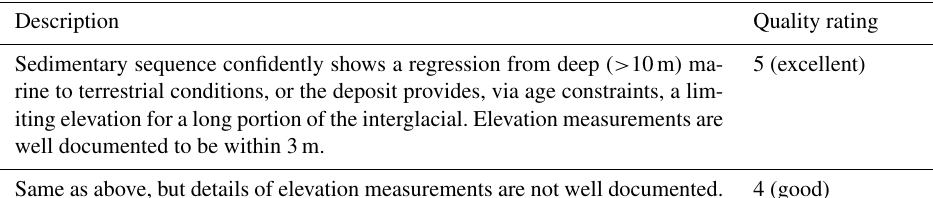
Table 3. Quality scores for sea-level proxies. Description Quality rating